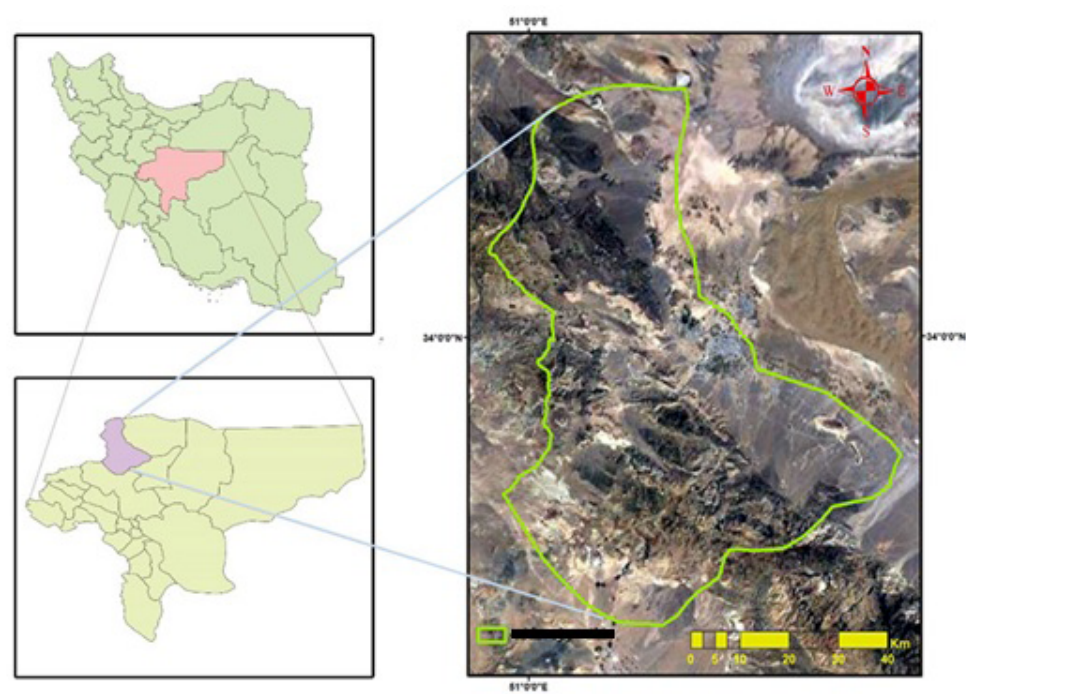
Figure 1. The location of the study are